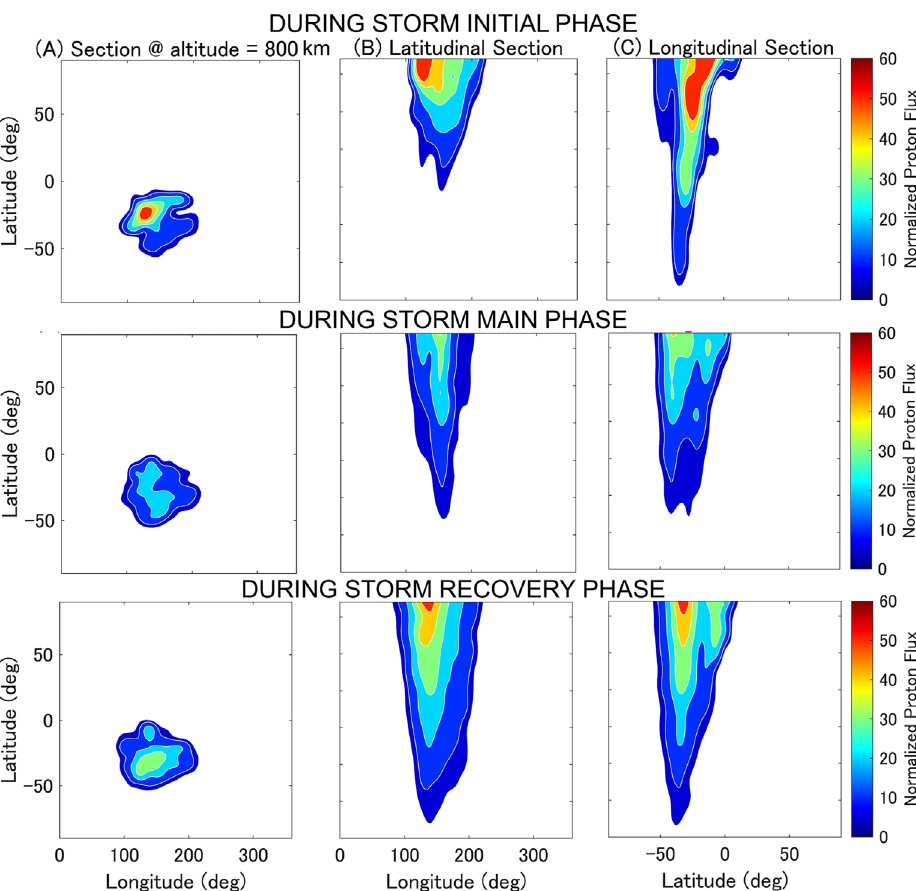
Fig. 6. The fi gure demonstrates the proton fl ux distribution during the three geomagnetic storm phases for the three different section views in the SAA. Note that the latitudinal and longitudinal sections were taken at the SAA center, de fi ned as the location of the maximum proton fl ux in the SAA 3D con fi